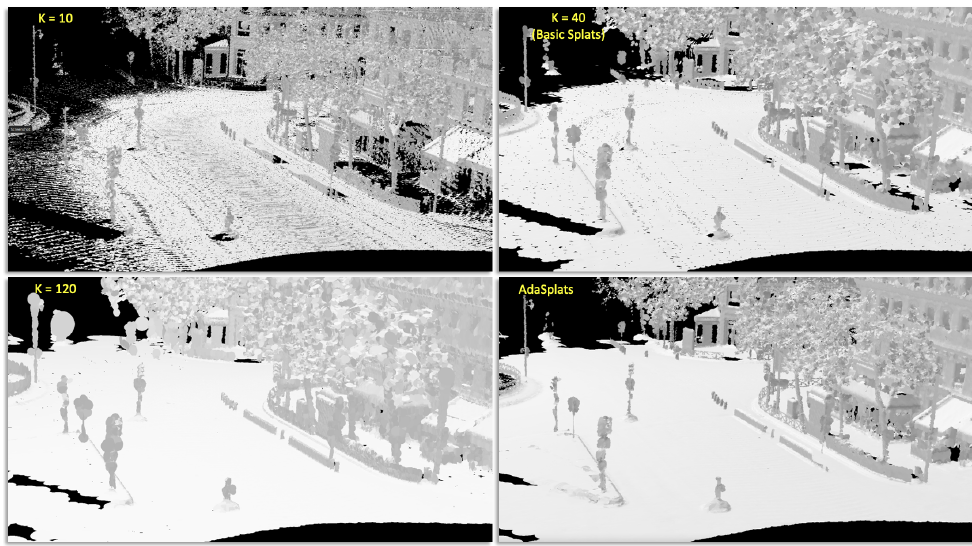
Figure 7. Rendering results on different choices of K -nn on PC3D-Paris dataset. A small K (e.g., 10 or 20) results in holes on the surface and ground groups while also resulting in a better approximation on the non-surface and linear groups. A large K (40 to 120) results in a hole-free approximation of the surface and ground semantic groups while creating artifacts on small structures belonging to the linear and surface